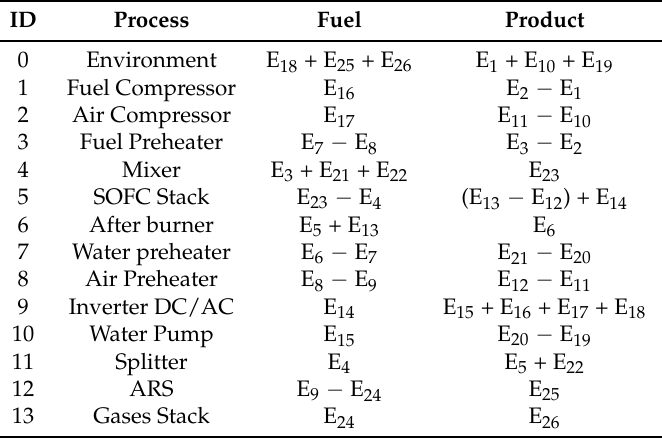
Table 5. Definition of the Fuel-Product table for the SOFC-VAR